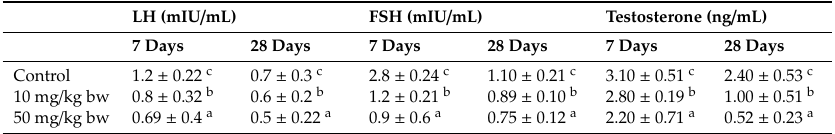
Table 4. E ff ects of sub-dermal administration of Ag-NP on LH, FSH, and testosterone of experimental